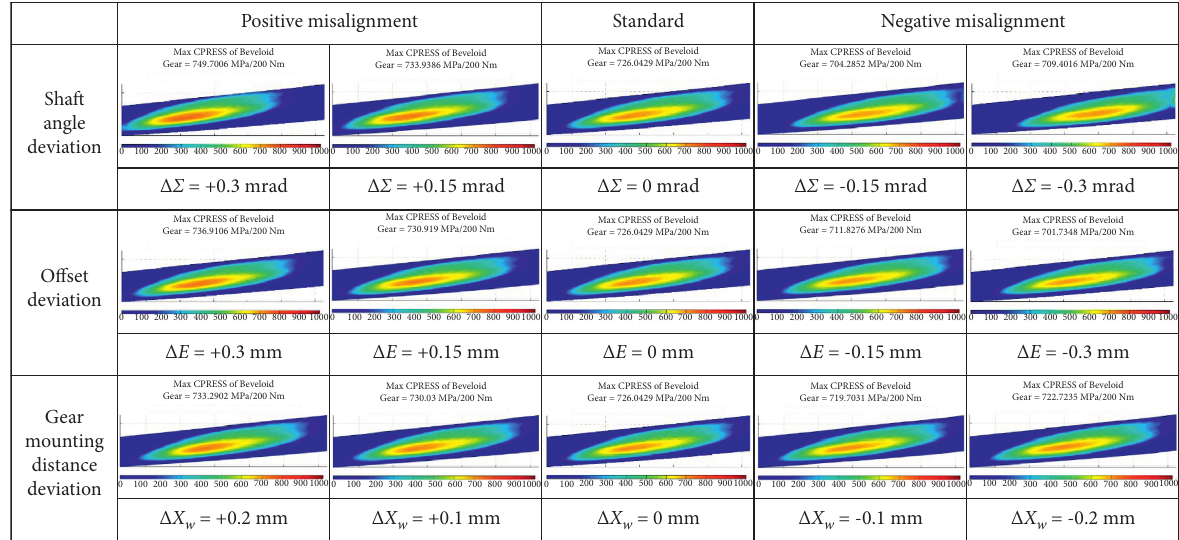
Figure 10: Contact patterns of beveloid gear under intentional